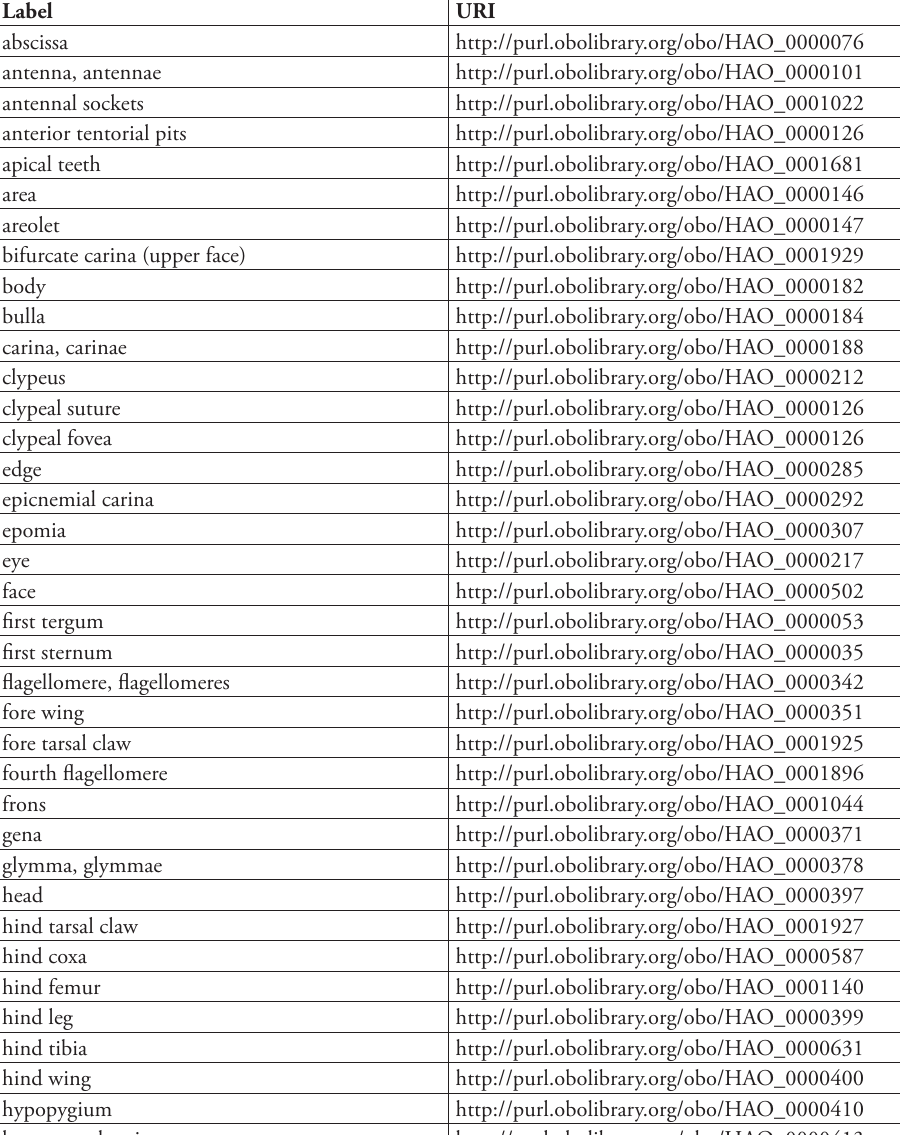
table 2. Morphological characters and URIs to concepts in the Hymenoptera Anatomy Ontology.